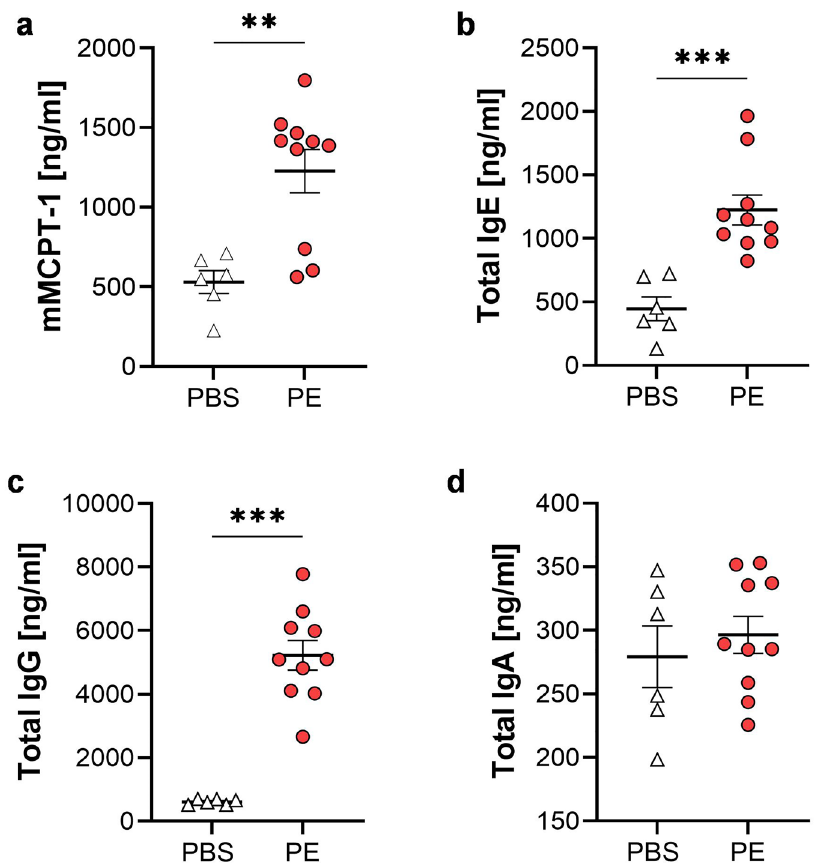
Figure 6. Local humoral response and mMCPT-1 in the small intestine. Levels of ( a ) mMCPT-1, ( b ) total IgE, ( c ) total IgG and ( d ) total IgA were determined in the supernatant of intestinal homogenates via ELISA. n = 6–10, data presented as combination of 2 experiments performed under identical settings; ** p < 0.01; *** p <